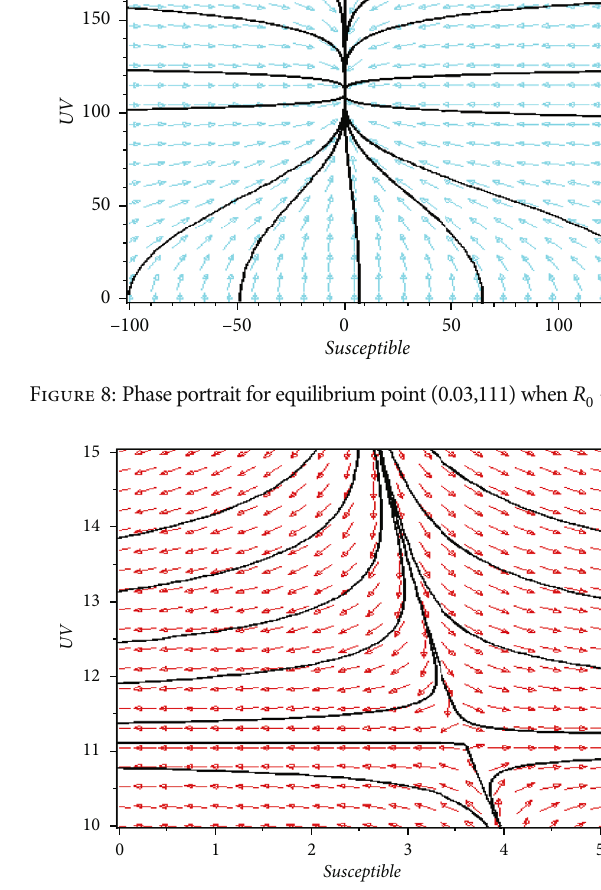
Figure 9: Unstable phase portrait for equilibrium point (2.6,11) when R 0 > 1